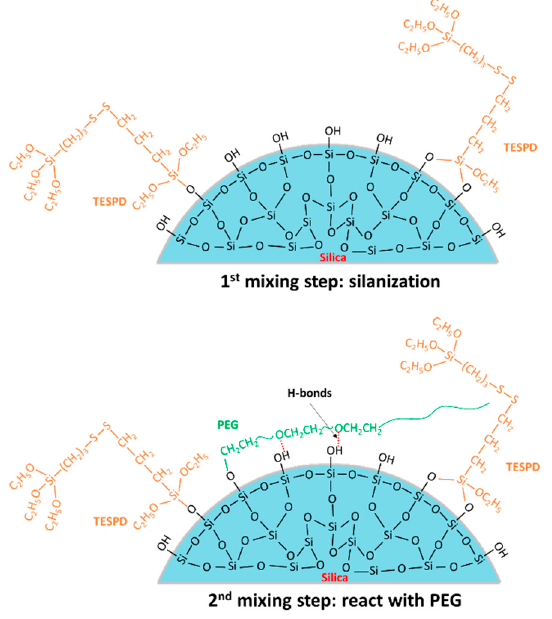
Figure 2. Schematic of the possible reaction mechanisms during the two mixing steps.